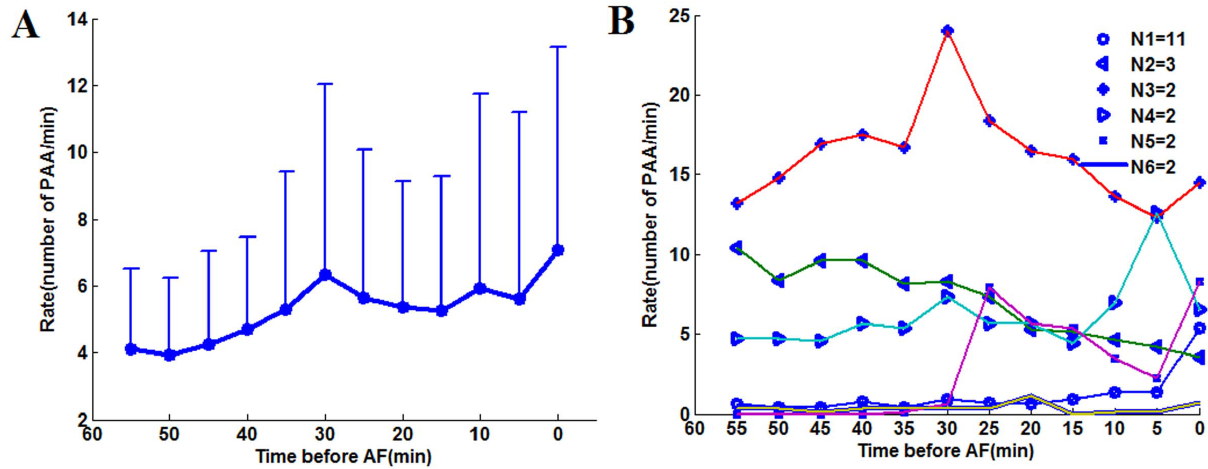
Figure 5. R PAA temporal evolution and the patterns of change. (A) Mean value and standard deviation of PAA rate within each 5 minutes in the last hour before AF; (B) Mean patterns associated to the clusters obtained by the analysis of the five minutes time series. The number of patients corresponding to each pattern is indicated in the legend. Only the patterns with more than one patient are shown. The abscissa is the time before the onset of AF